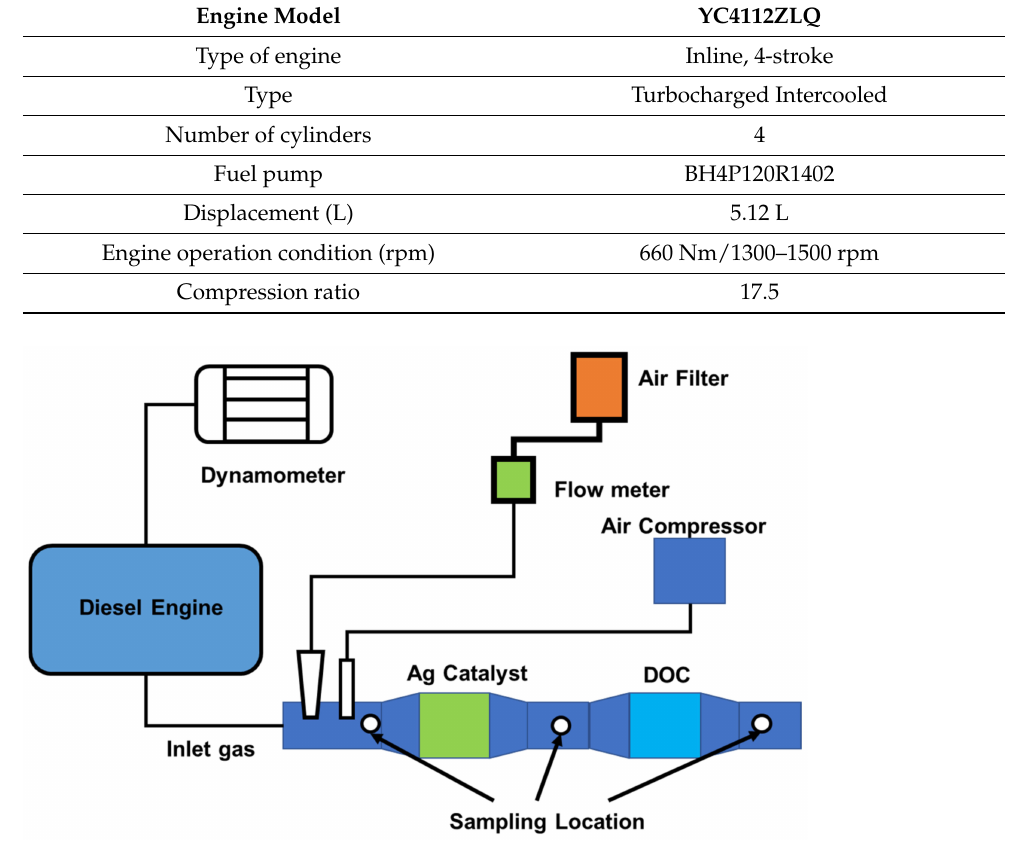
Figure 16. Schematic of engine testing